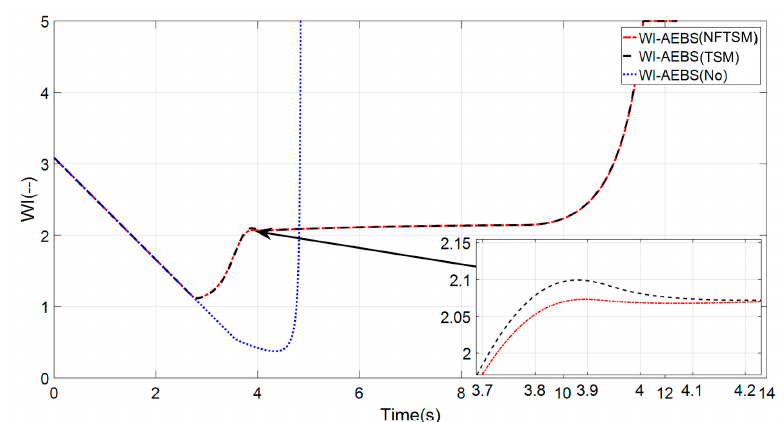
Figure 15. Comparison of